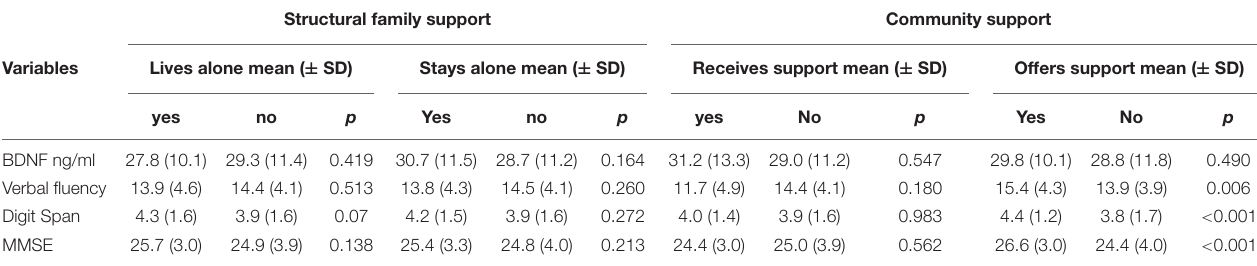
TABLE 2 | Association between family structure, community support, BDNF and cognitive performance ( n = 386). Structural family